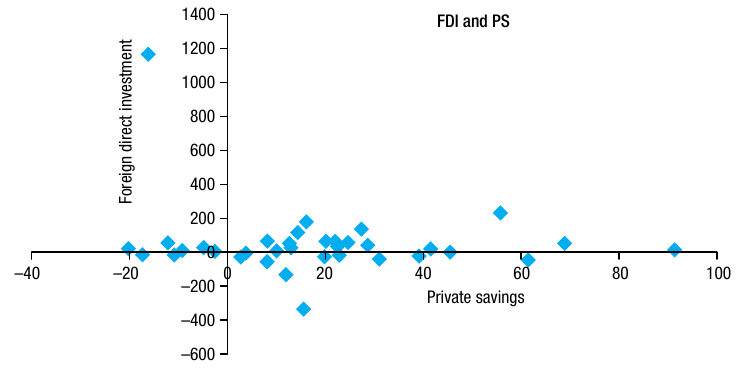
Fig. 1. Foreign direct investment and private savings